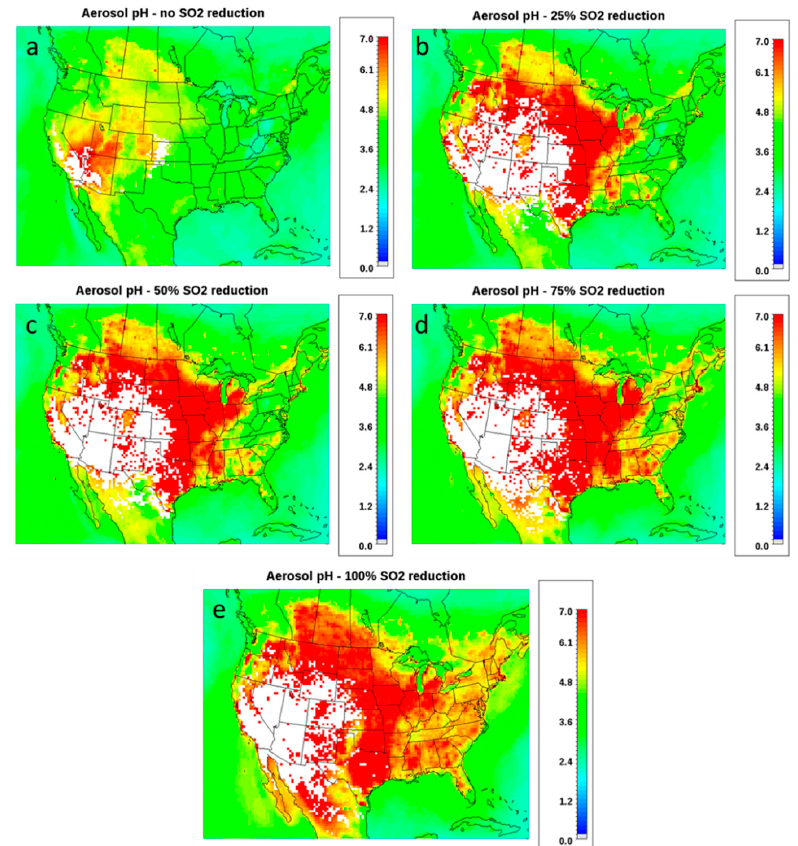
Figure 9. Simulated pH fields over the CONUS for no reductions ( a ), 25% ( b ), 50% ( c ), 75% ( d ) and 100% ( e ) SO 2 emission reductions. White areas have zero inorganic water and therefore pH is not predicted for them.